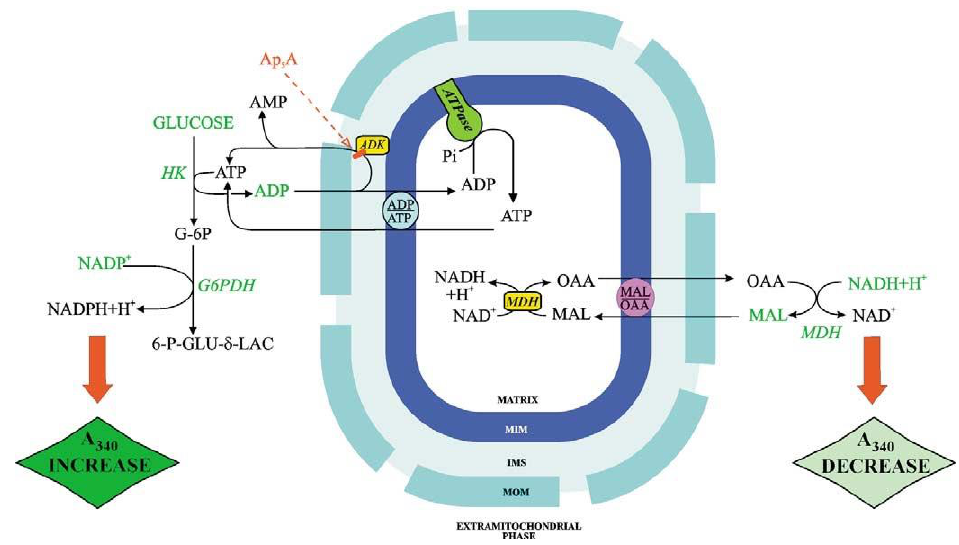
Figure 3. The ATP and the OAA detecting systems. The externally added components of the ATP and OAA detecting systems are reported in green. Main abbreviations: ADK, adenylate kinase; Ap 5 A, P1,P5-di(adenosine- 5′ )penta-phosphate; G6PDH, glucose-6-phopshate dehydrogenase; 6-P-GLU-d-LAC, 6-phosphoglucono-d-lactone; HK, hexokinase. From Passarella et al. [9]. With permission from Elsevier, 2021.